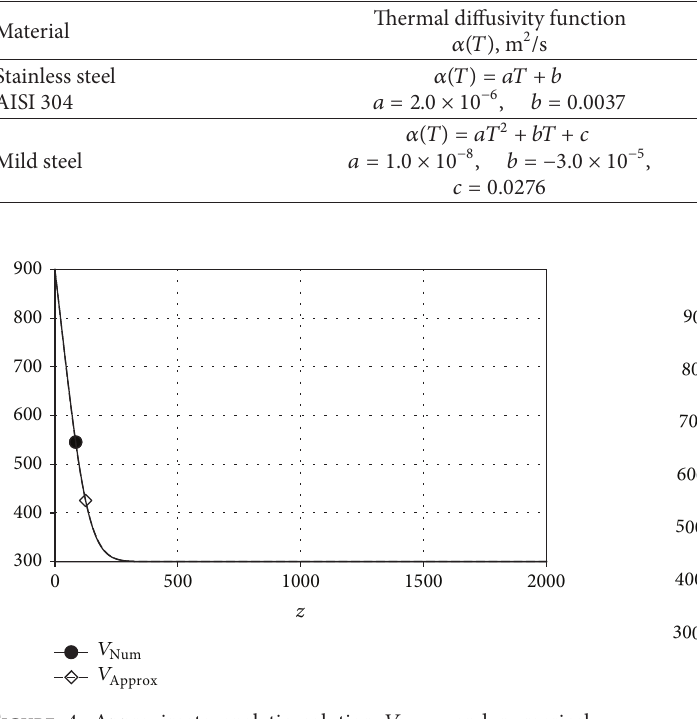
Figure 4: Approximate analytic solution 𝑉 of BVP (19), (20). solution 𝑉 Num